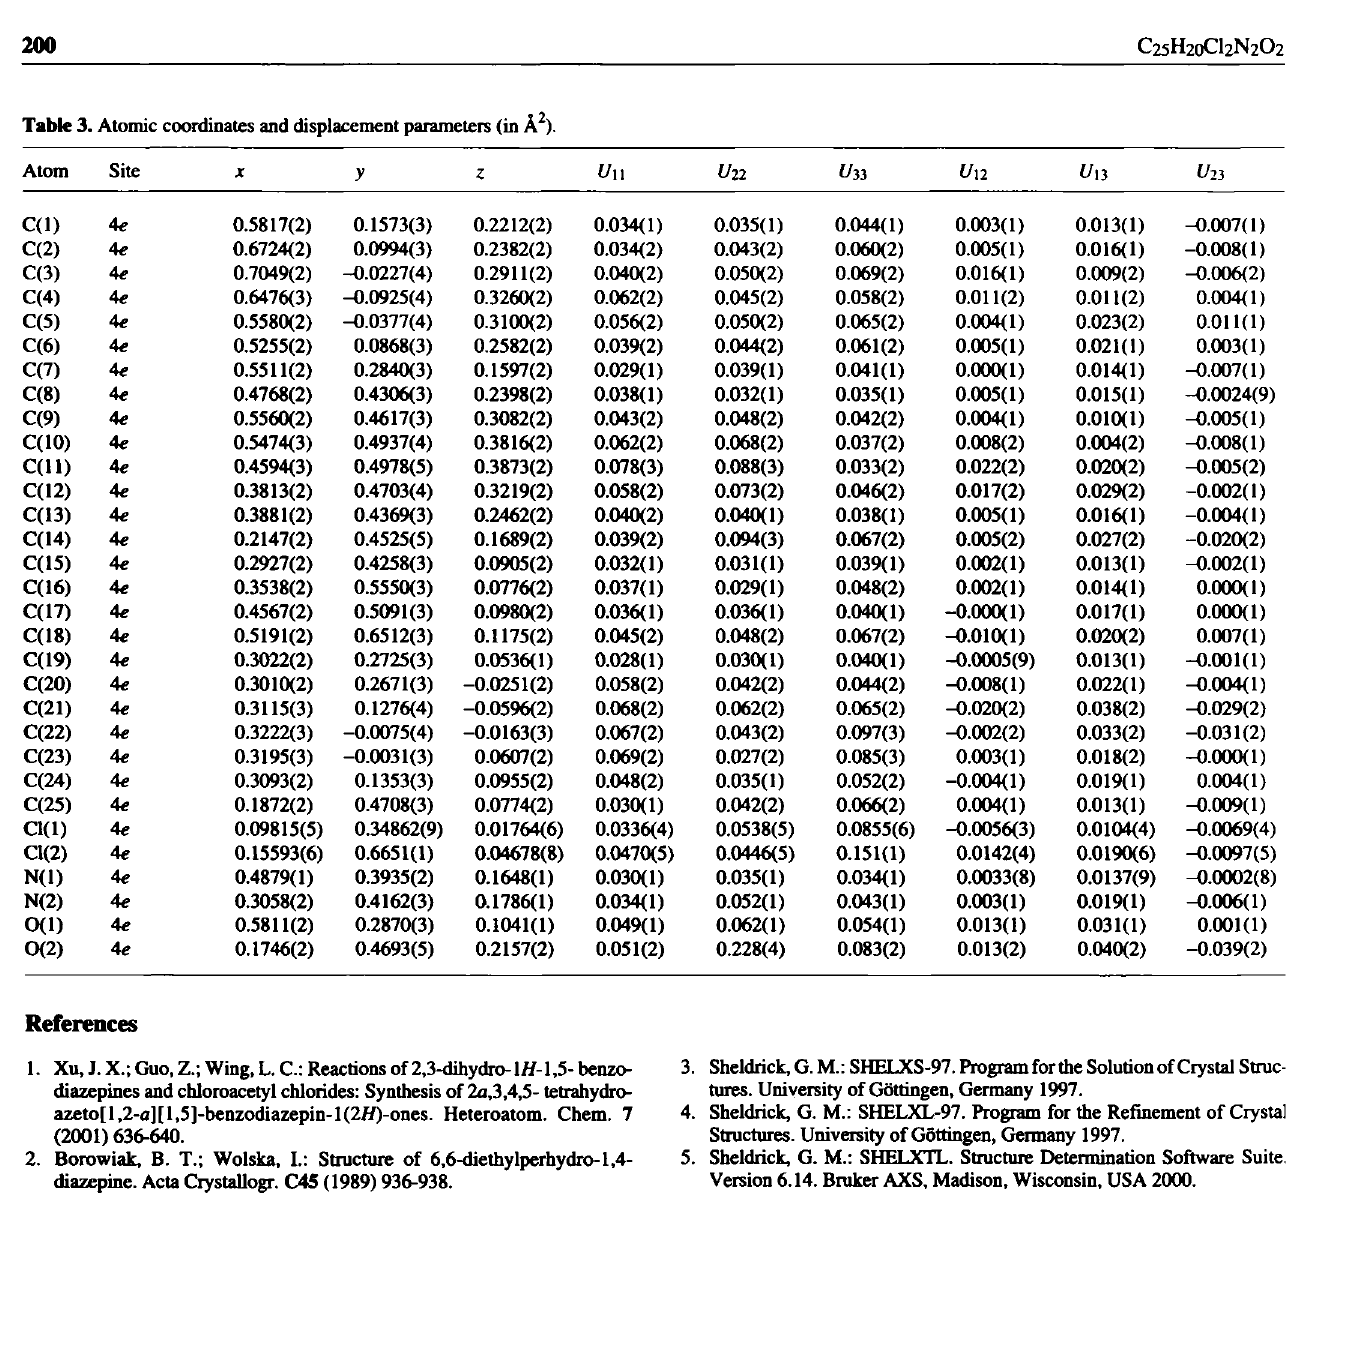
Table 3. Atomic coordinates and displacement parameters (in Â 2